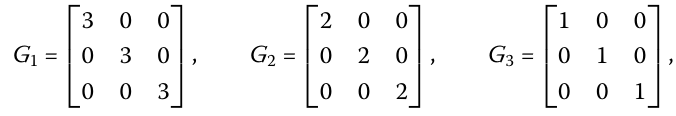
),0.7sin( 2 π ),0.75sin( 2 π )). 15 15 15